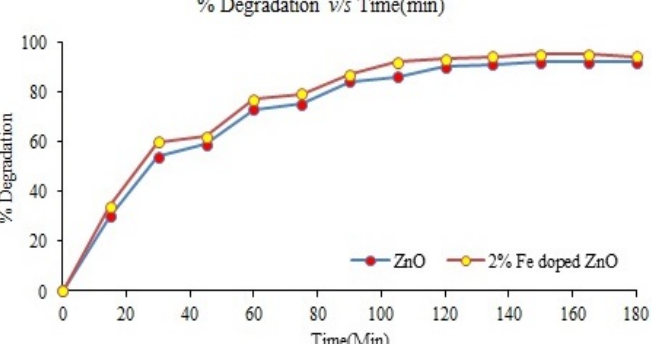
Fig. 8. Effect of contact time on photocatalytic degradation of MB dye under conditions: pH=2, dye concentration 10 mg/L and catalyst (ZnO and 2% Fe-ZnO) dose 1 g/L irradiation time 180 min.